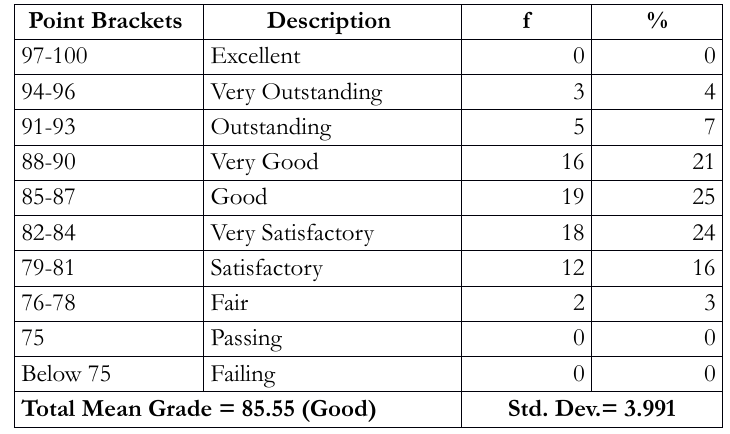
Table 3. Academic Performance of the Respondents 3.4. Tests of Difference on the Learning Styles when Grouped According to Profile Variables